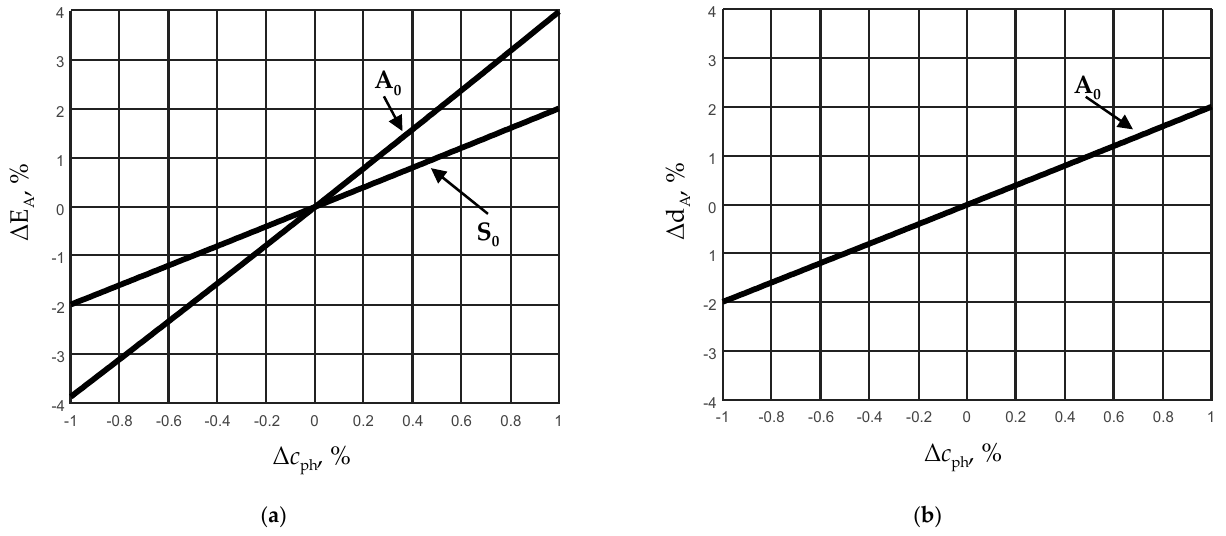
Figure 12. Measurement uncertainties of the Young’s modulus E ( a ) and film thickness d ( b ) versus phase velocity c ph measurement errors of A 0 and S 0 modes.